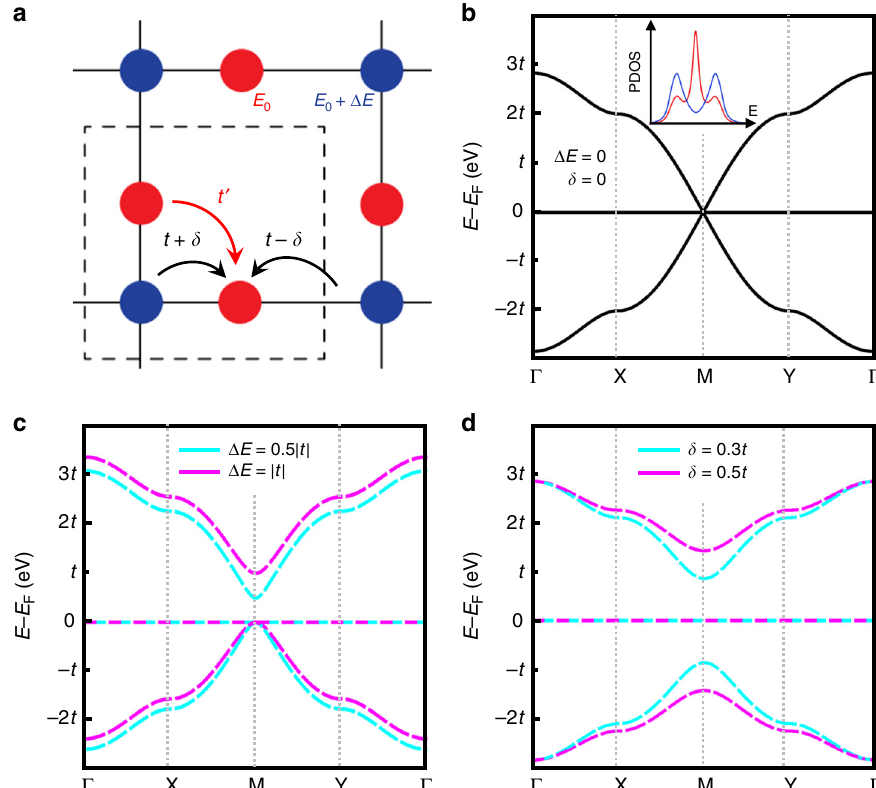
Fig. 1 Lieb lattice. a A Lieb-3 lattice with four key parameters, i.e., the on-site energy difference Δ E , the dimerization interaction δ between the corner (blue) and the edge-center (red) sites, and the NN and the NNN hopping integral, t and t ’ , respectively. b Band structure of an ideal Lieb lattice with Δ E , δ , and t ’ all equal to zero. The inset shows the projected density of states (PDOS) with blue and red lines corresponding to the corner and edge-center states, respectively. c Band structures with different positive Δ E . d Band structures with different δ